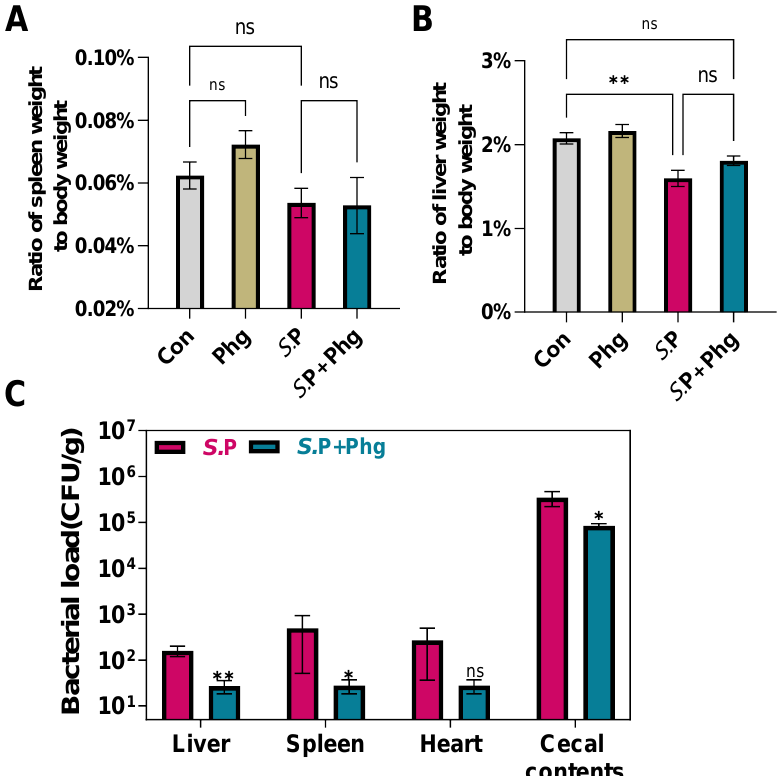
Figure 5. Phage CKT1 reduced the S. Pullorum load in various tissues of adult breeders. The ratio of spleen weight to body weight ( A ) and the ratio of liver weight to body weight at day 6 ( B ). ns, p > 0.05 (ordinary one-way ANOVA and post hoc Tukey’s test); ** p < 0.01. ( C ) S. Pullorum load in tissues at day 6. n = 5. ns, p > 0.05 (Mann–Whitney test); * p < 0.05; ** p < 0.01. S .P, only Salmonella challenged; Con, the control group; Phg, only phage treated; S .P + Phg, Salmonella challenged and phage treated.